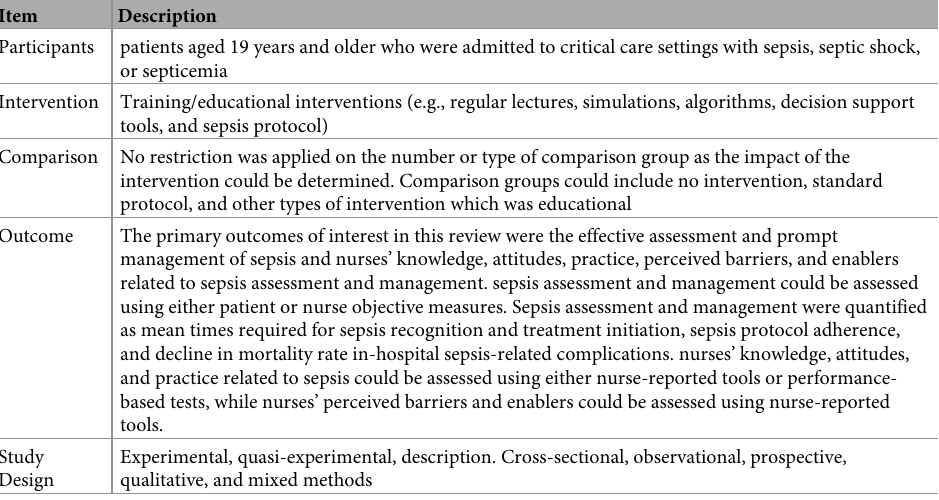
Table 1. The construction of review questions according to PICOS